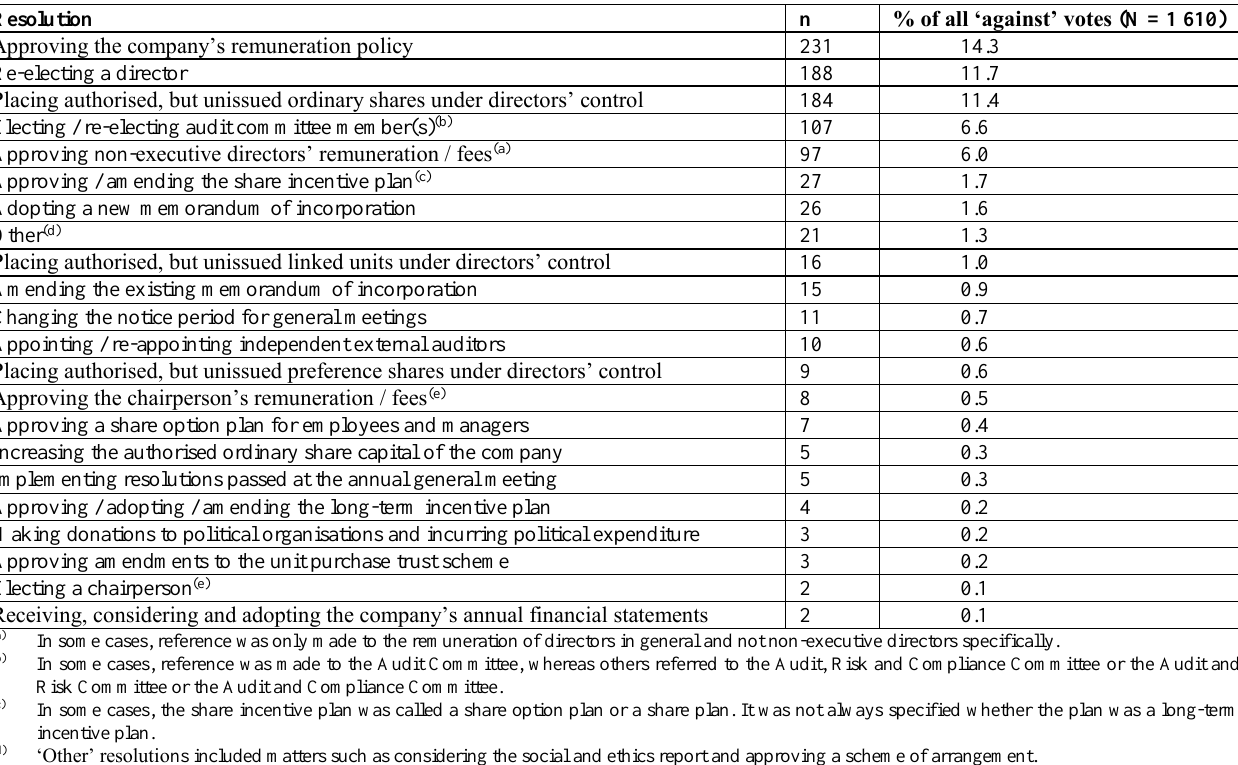
Table 4: Corporate governance-oriented resolutions attracting ‘against’